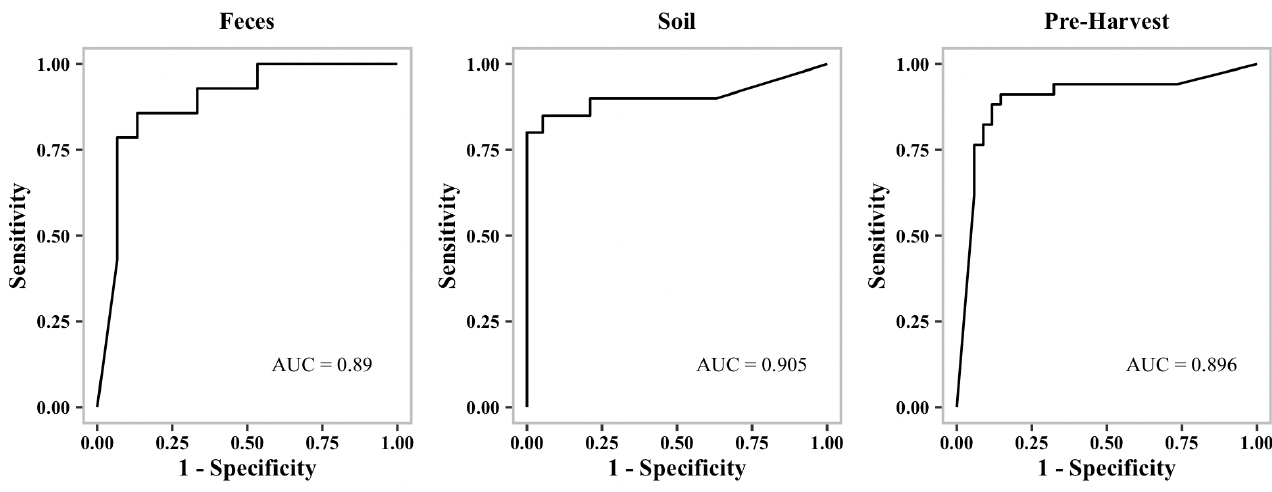
Figure 3. Receiver operating characteristic curve (ROC curve) of Listeria MDR predictive